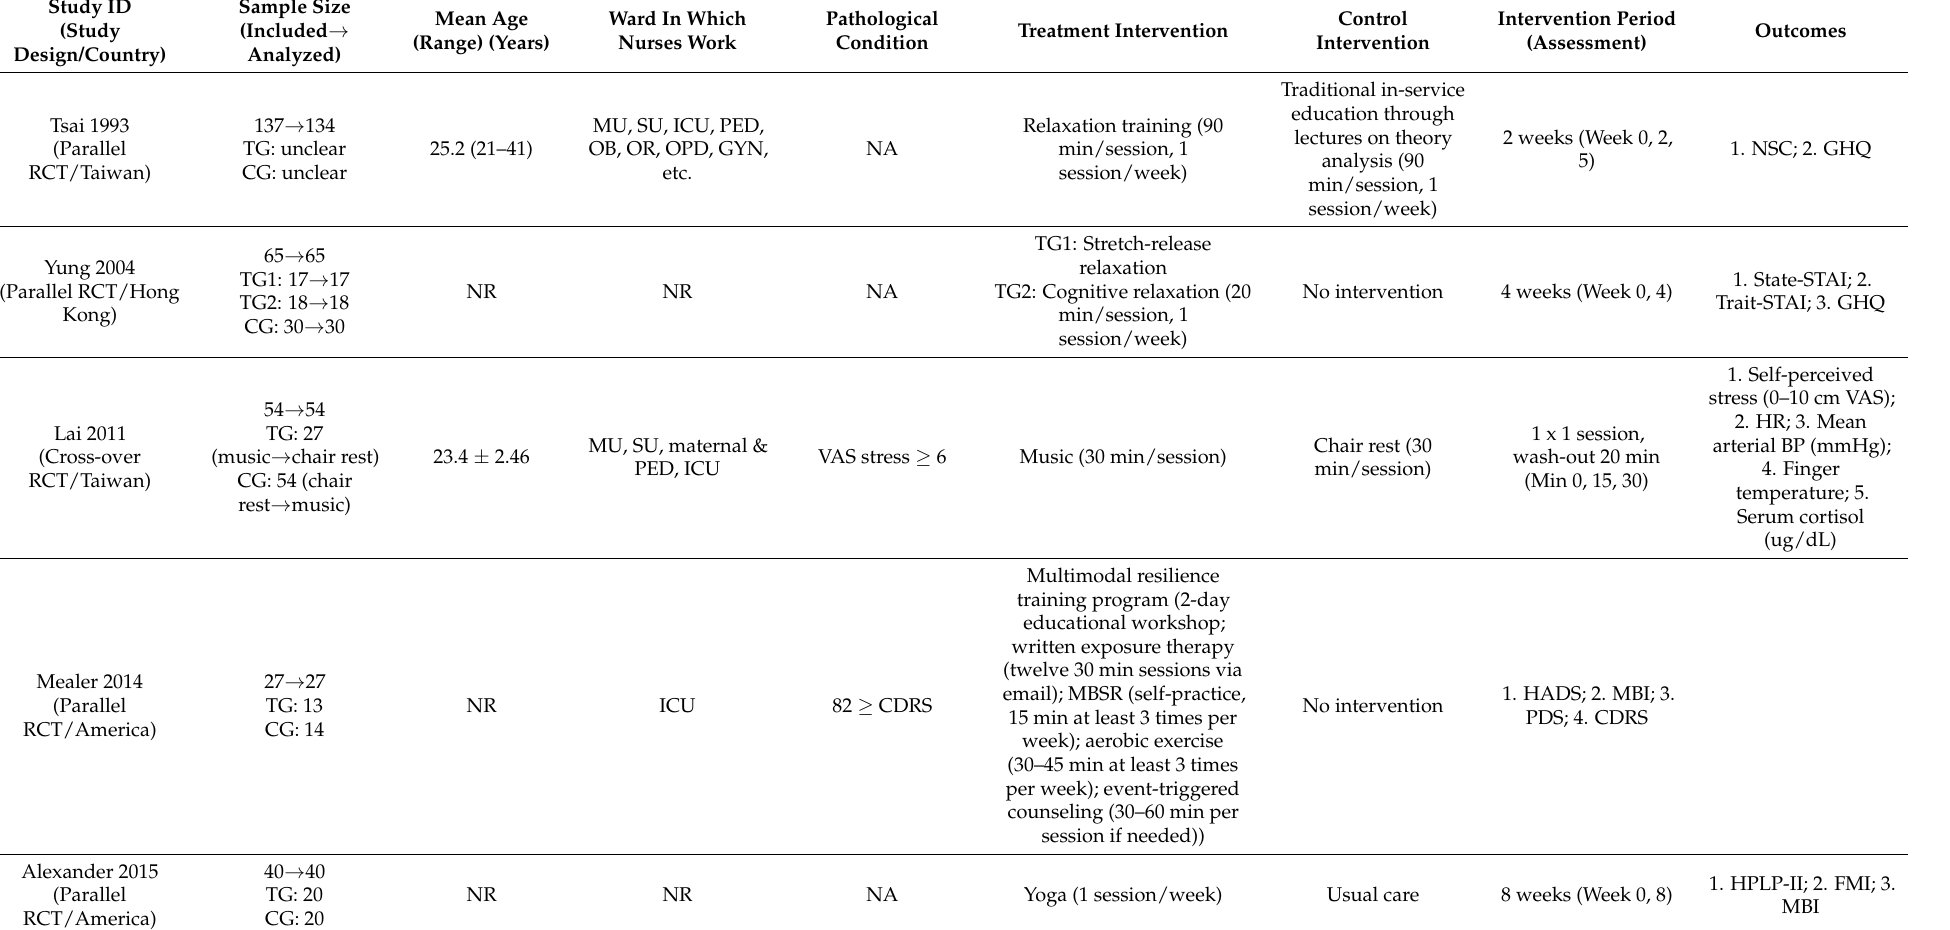
Table 1. Characteristics of included